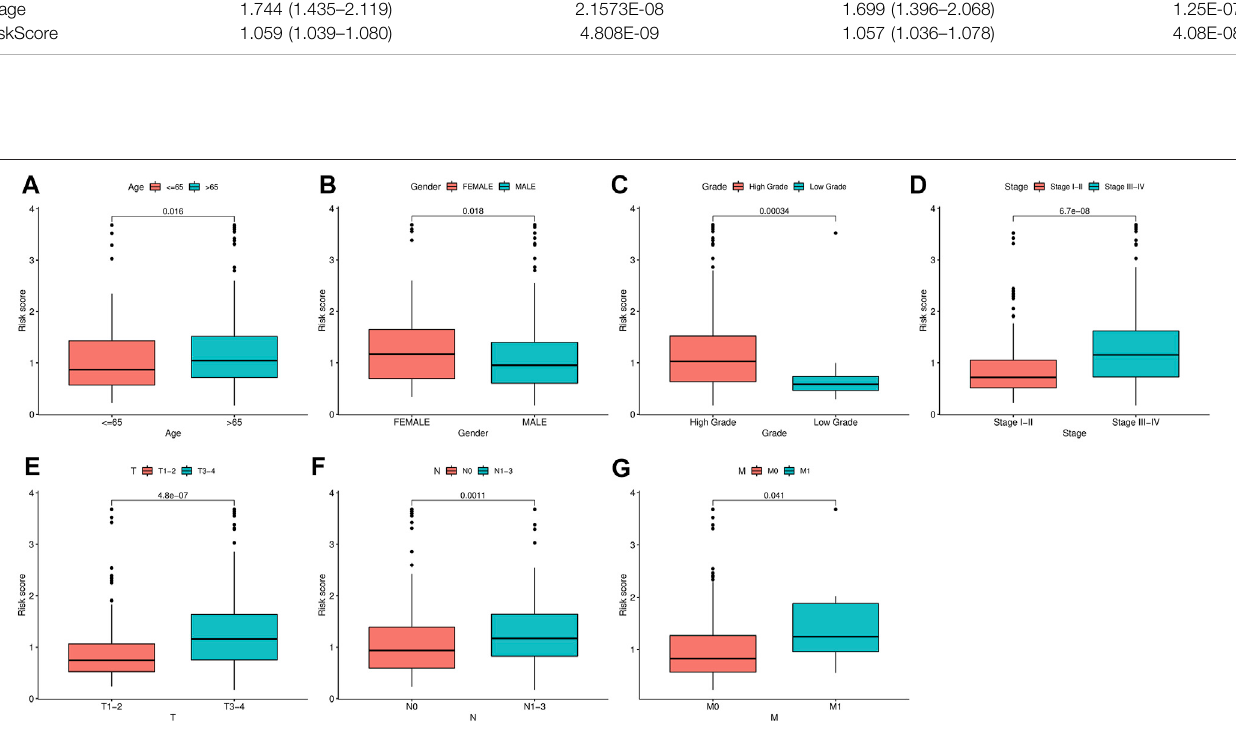
Frontiers in Genetics |